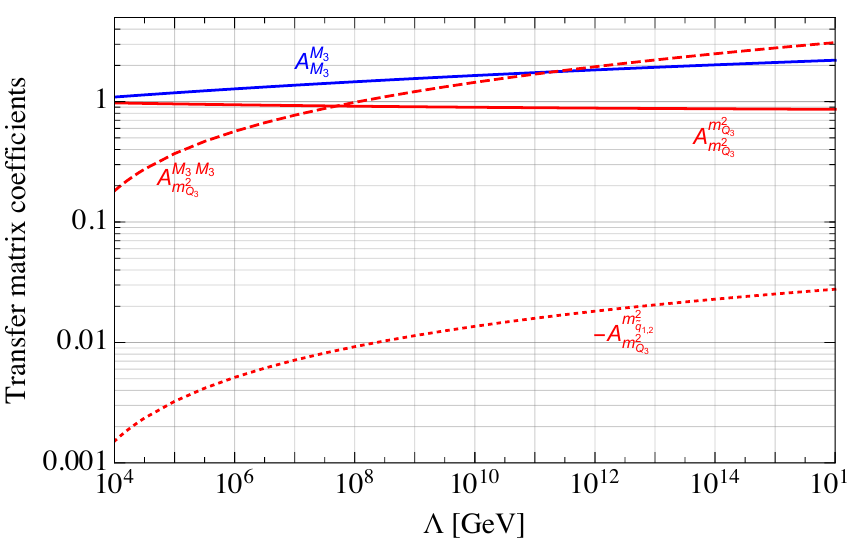
(red), as function of Q 3 m 2 ~ q 1 ; 2 is negative, unlike the m 2 Q 3